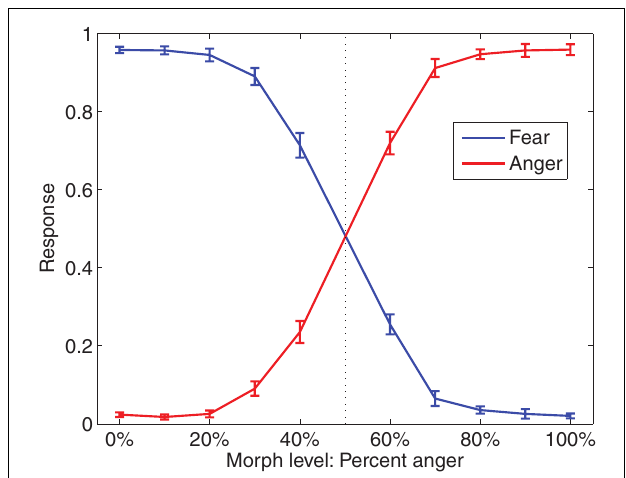
FIGURE 5 | Fraction of anger decisions (red) and fear decisions (blue) at each morph level. The vertical dotted line is the category boundary. Error bars are the standard error of the mean over subjects. Throughout this report, k% anger implicitly means (100-k)% fear.